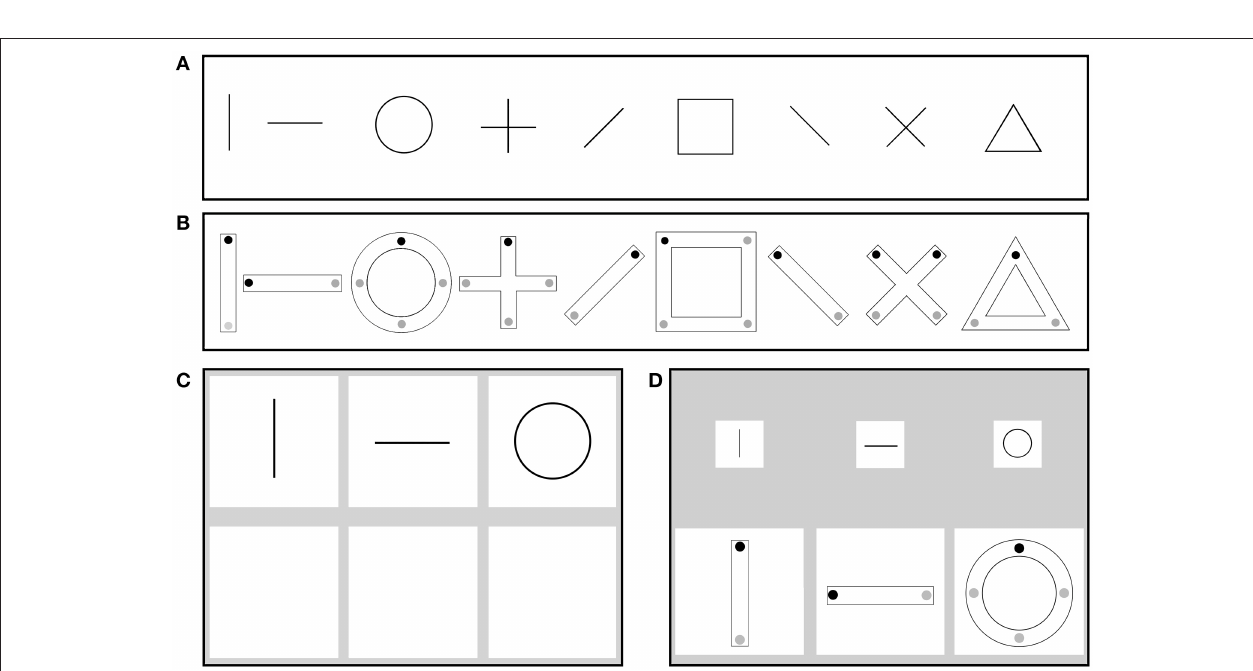
FIGURE 2 | The first nine forms of the Visual-Motor Integration task (A) and the Motor Coordination task (B) (Beery and Beery, 2010). The writing space of the VMI (C) and the MC (D) . Reprinted from Gerth et al. (2016) with permission from Elsevier.